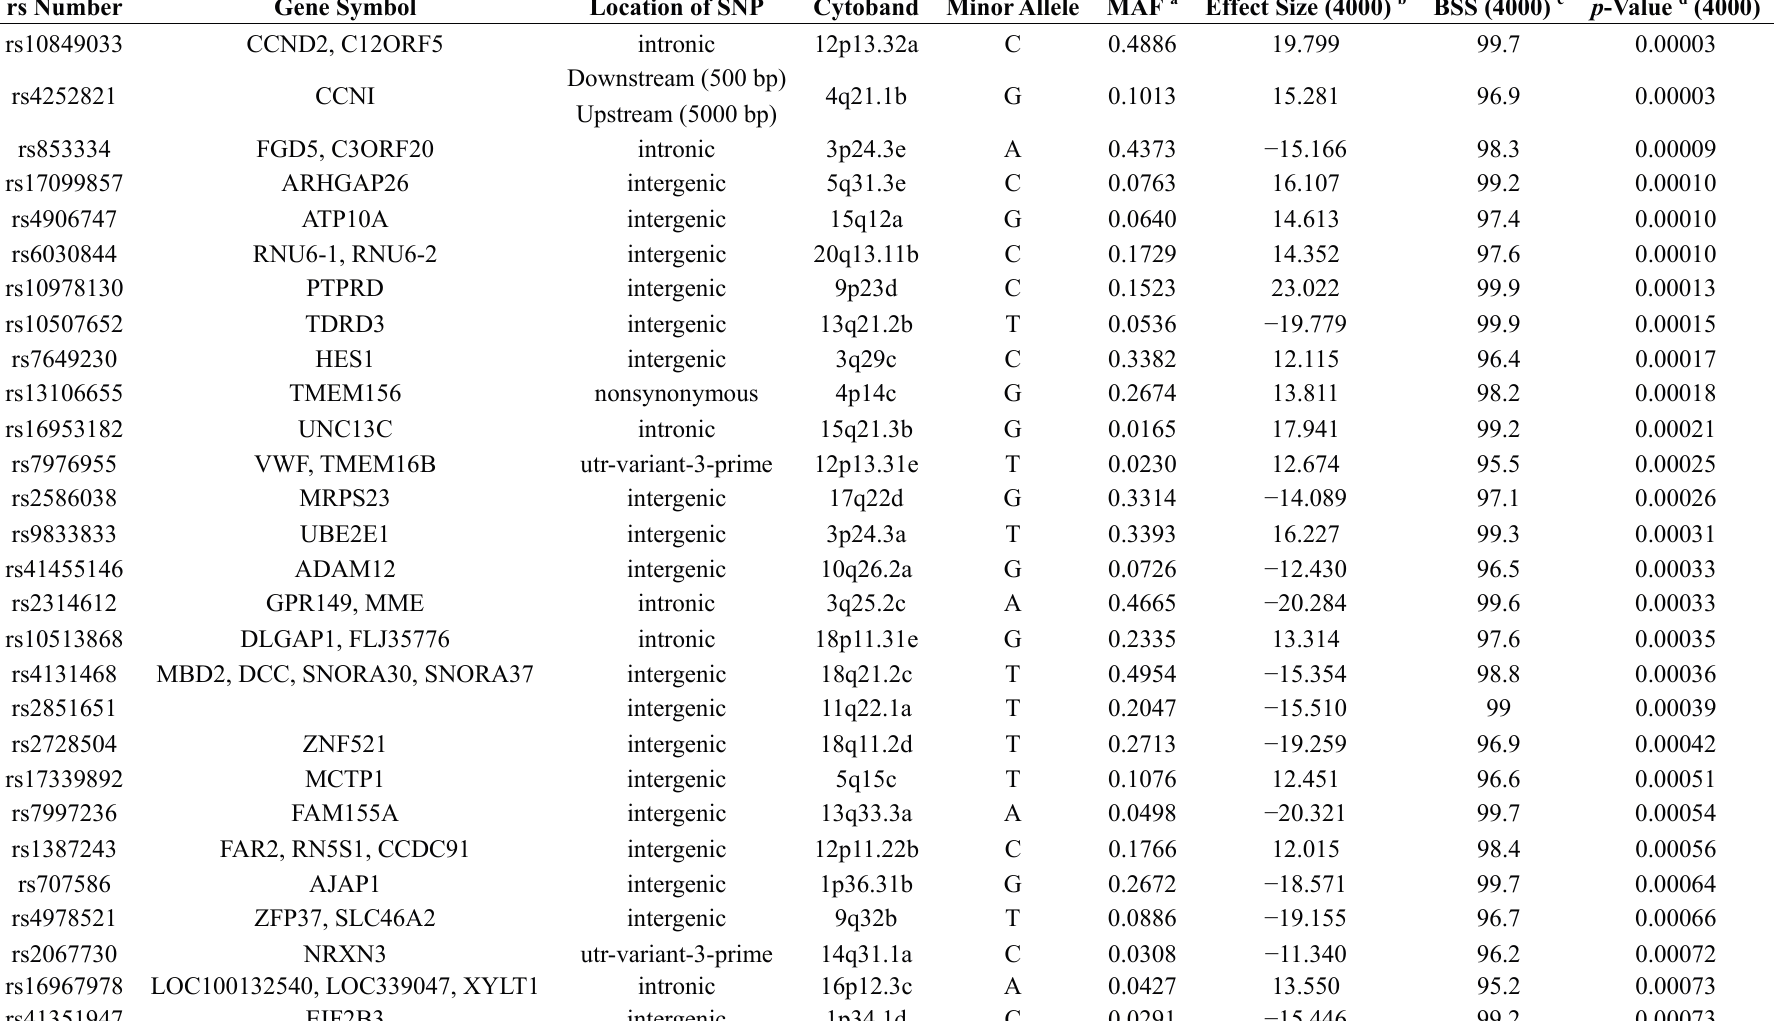
Table 2. SNPs associated with physical activity with bootstrap selection stability (BSS) ≥ 95% in top 1000, top 2000, top 3000, and top 4000 SNPs through a multi-stage